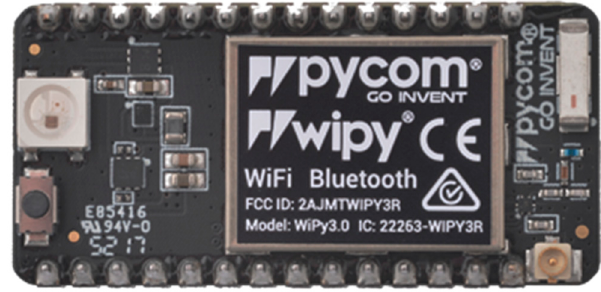
Figure 2. WiPy 3.0 development board based on ESP32 chip.